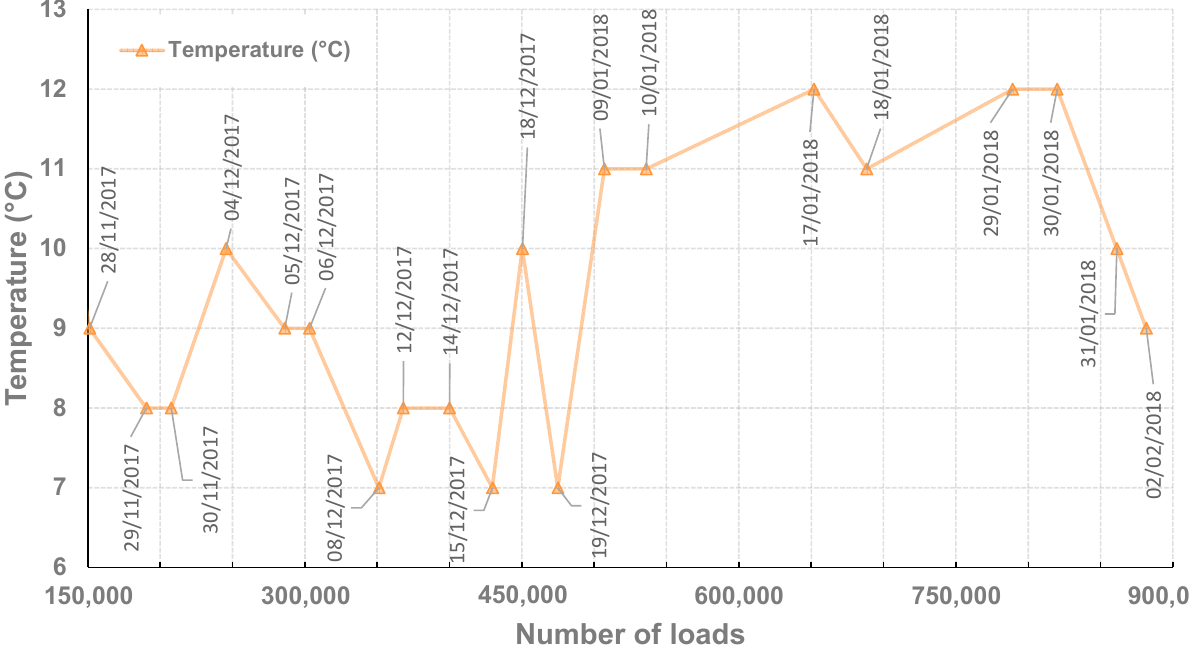
model. The Section 4 describes the model and the numerical tool used to simulate the strain gauge signal.